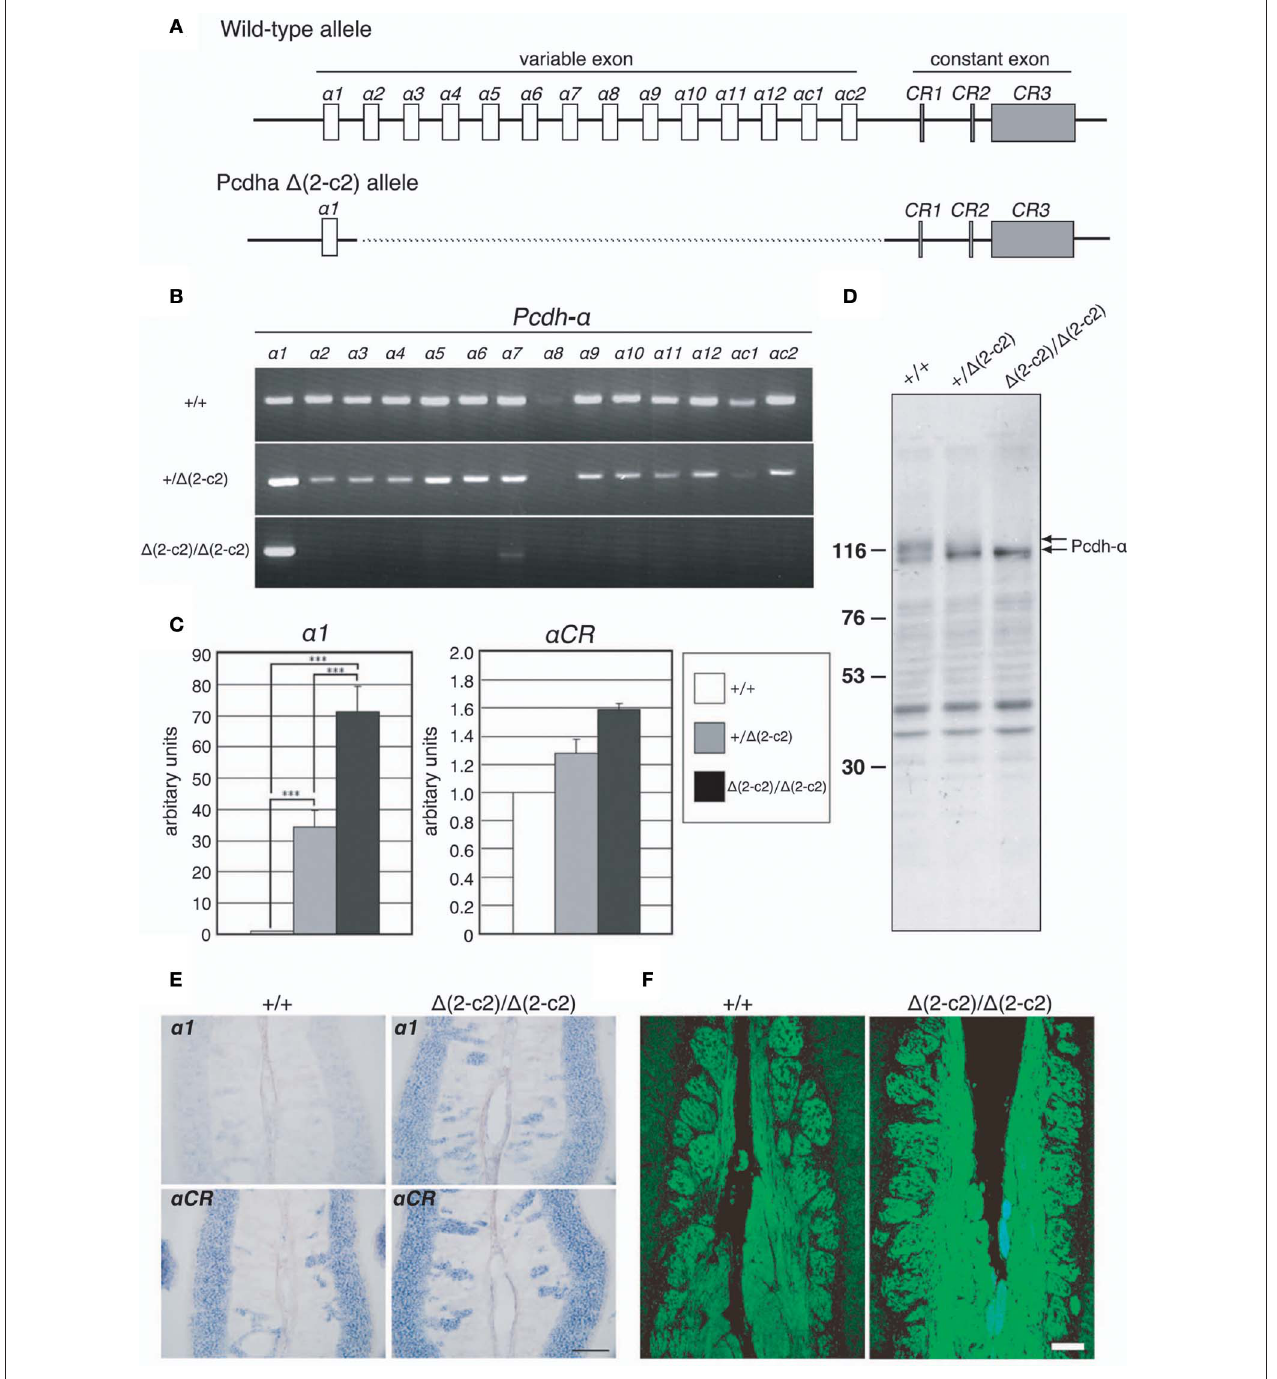
FIGURE 6 | Pcdha (cid:2)( 2–c2 )/(cid:2)( 2–c2 ) deletion mutant mice. (A) Wild-type Pcdh- α genes consist of variable-region ( α 1 to α 12 , α c1 and α c2 ) and constant-region ( CR1 – CR3 ) exons.The individual variable exonsare transcribed from their own promoters. A Pcdh- α transcript is produced from one variable exon and three or four constant exons by splicing. In the Pcdha (cid:2)( 2–c2 )/(cid:2)( 2–c2 ) mice, exons α 2– α c2 were deleted, leaving only exon α 1 in the variable region. (B) RT-PCR analysis of brain extracts of WT ( + / + ), Pcdha + /(cid:2)( 2–c2 ) [ +/ (cid:2) (2–c2) ], and Pcdha (cid:2)( 2–c2 )/(cid:2)( 2–c2 ) (cid:2) (2–c2/ (cid:2) 2–c2 ) mice. (C) qRT-PCR analysis of α 1 transcripts in the brain of WT ( + / + ), Pcdha + /(cid:2)( 2–c2 ) [ +/ (cid:2) (2–c2) ], and